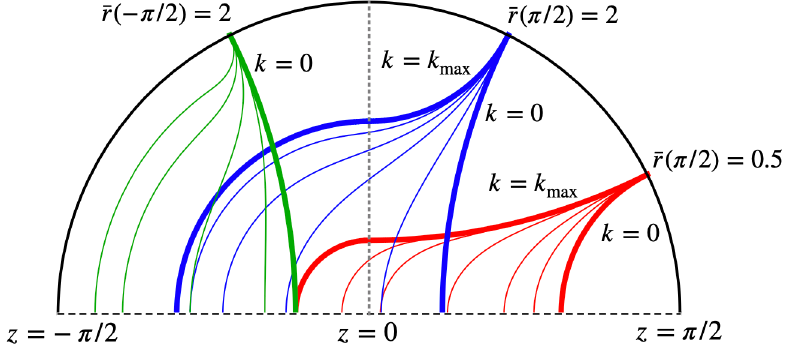
Figure 7 . Single droplets with different boundary radii embedded in the Poincaré disk. Each curve represents the horizon with its exterior to the left, and therefore, one can identify the blue and red curves as the single droplets in usual sense, while the green ones occupy more than the half of the disk, and hence looks more like a black cavity which is also found in the Poincaré AdS setup [17]. The blue and red branches have the minimum and maximum shapes which admit minimum and maximum value of the surface gravity respectively. In contrast, the green branch only has the minimum solution and admit arbitrary large surface